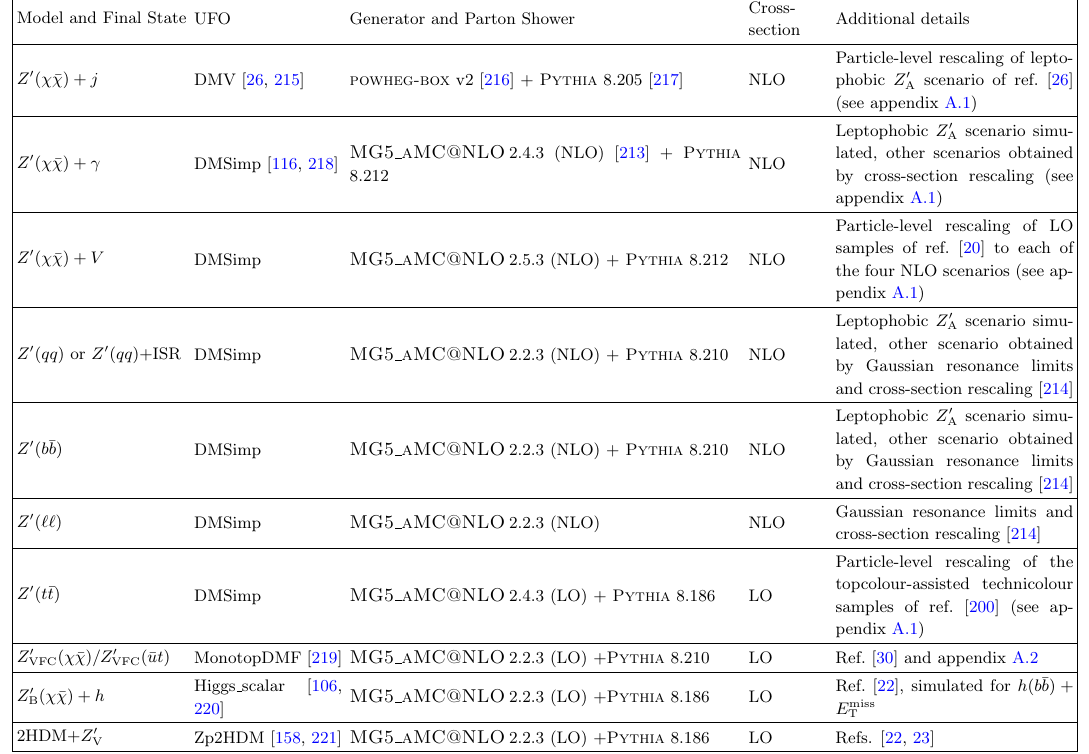
Table 4. Details of the generation setup and Universal FeynRules Output (UFO) model used